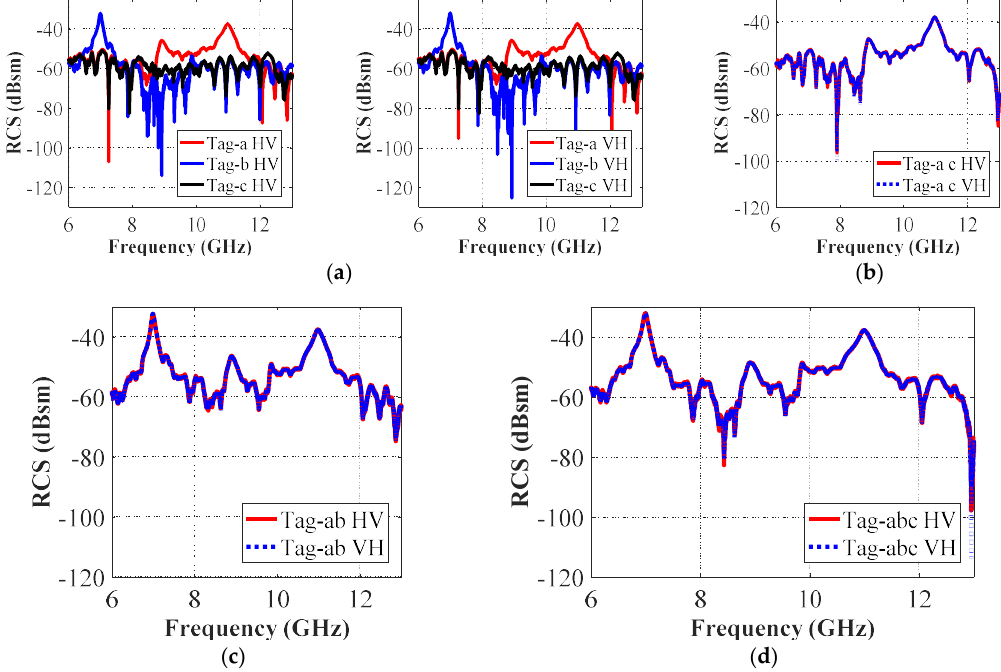
Figure 25. Measurement cross-polar (HV/VH) RCS results: ( a ) Tag-a, -b, and -c; ( b ) Tag-a; ( c ) Tag-ab; ( d ) Tag-abc. Table 5. Tag-ID Letters’ digital code and resonant frequency signatures (GHz) (ø represents no letter). Tag-ID